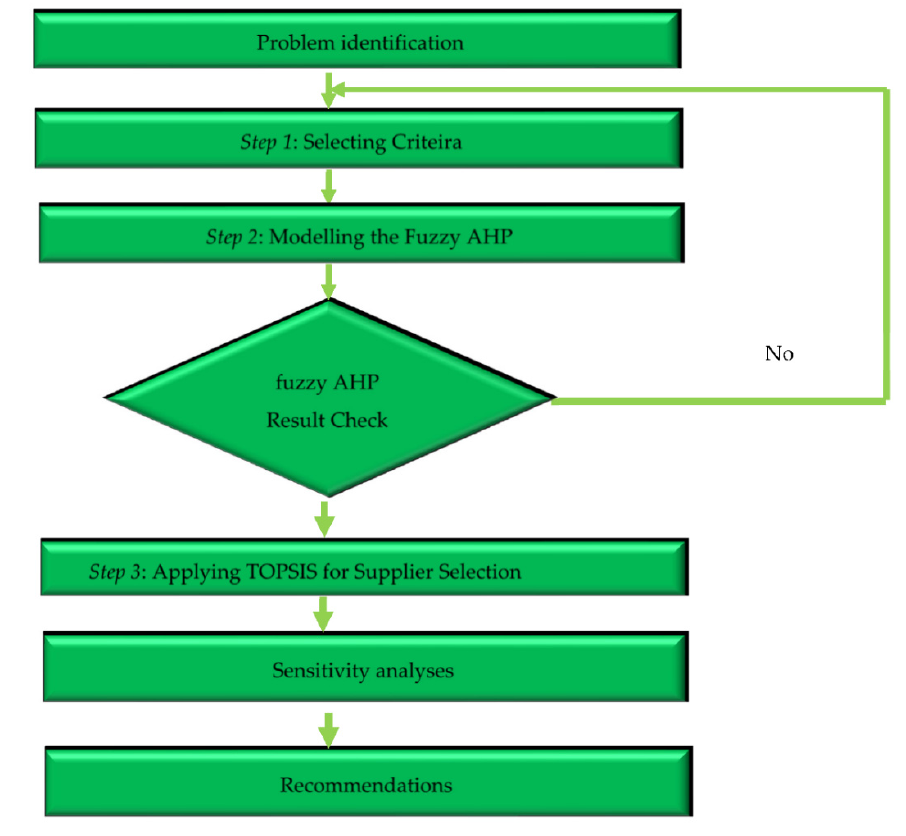
Figure 3. Research graph.